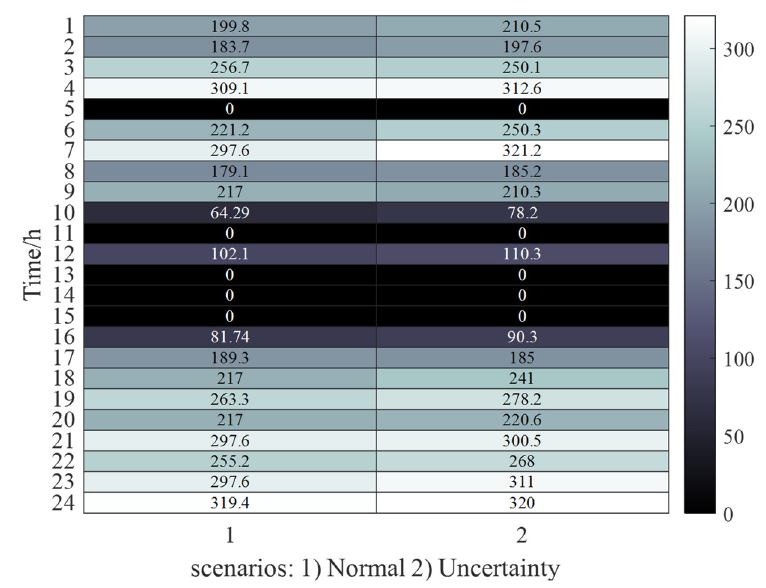
Figure 12. The output power of wind turbines for both scenarios.